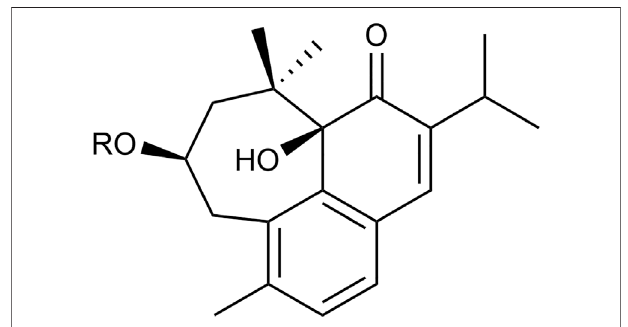
FIGURE 7 | Abietane